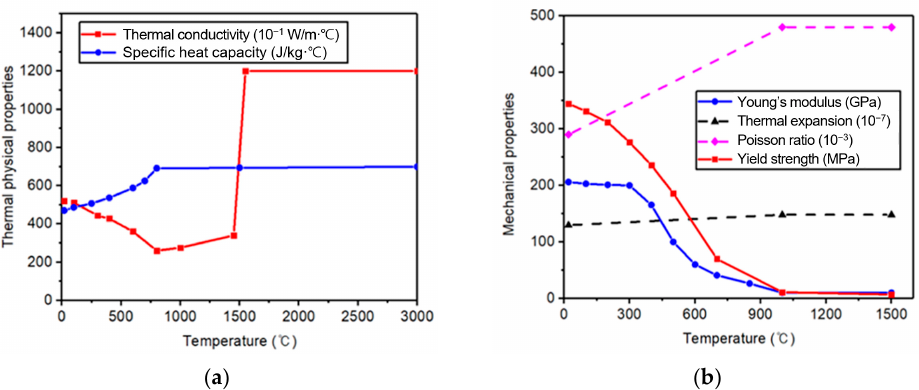
Figure 7. Temperature-dependent material properties of AH36 steel plate: ( a ) thermal properties and ( b ) mechanical properties.